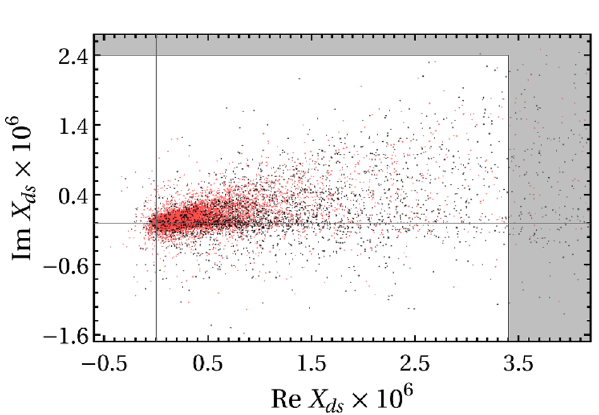
Figure 4 . Scatter plot (red and black) for the real and imaginary parts of X ds for the NB-VLQ model. In black we show the points excluded from R b ; cf. (8.14). The shaded area is excluded by (8.15).